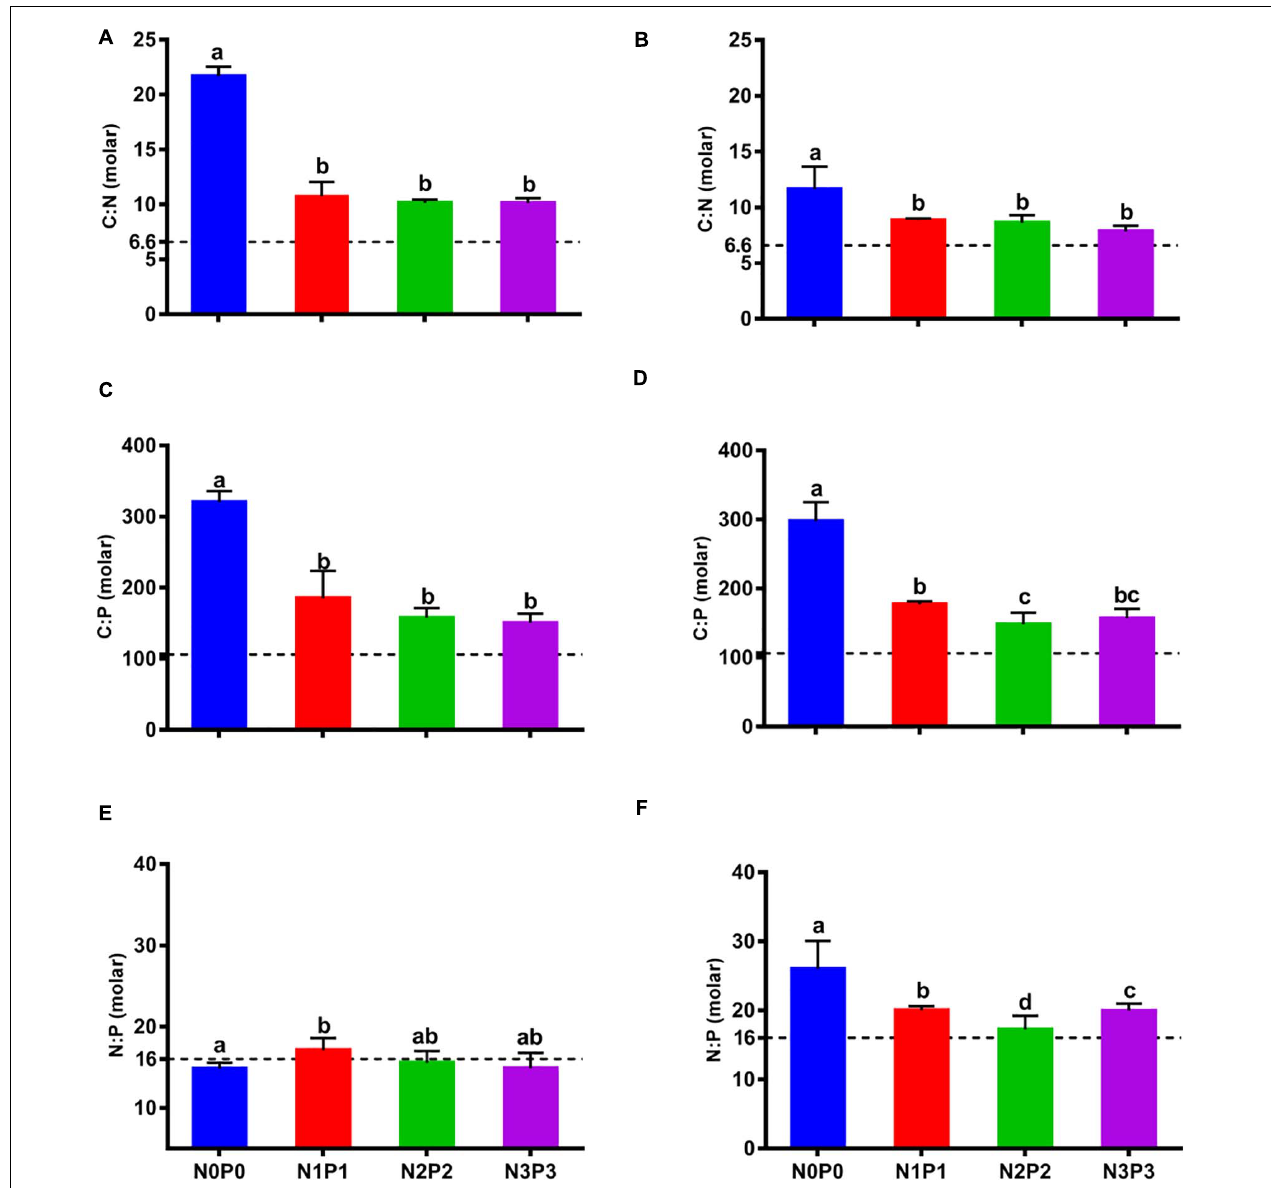
FIGURE 4 | Elemental ratios of Z-61 (A,C,E) and Z-26 (B,D,F) in the four nutrient treatments. Error bars denote standard deviations of averaged results from four replicate bottles. The straight horizontal dotted line indicates the Redfield ratio (C:N:P = 106:16:1).